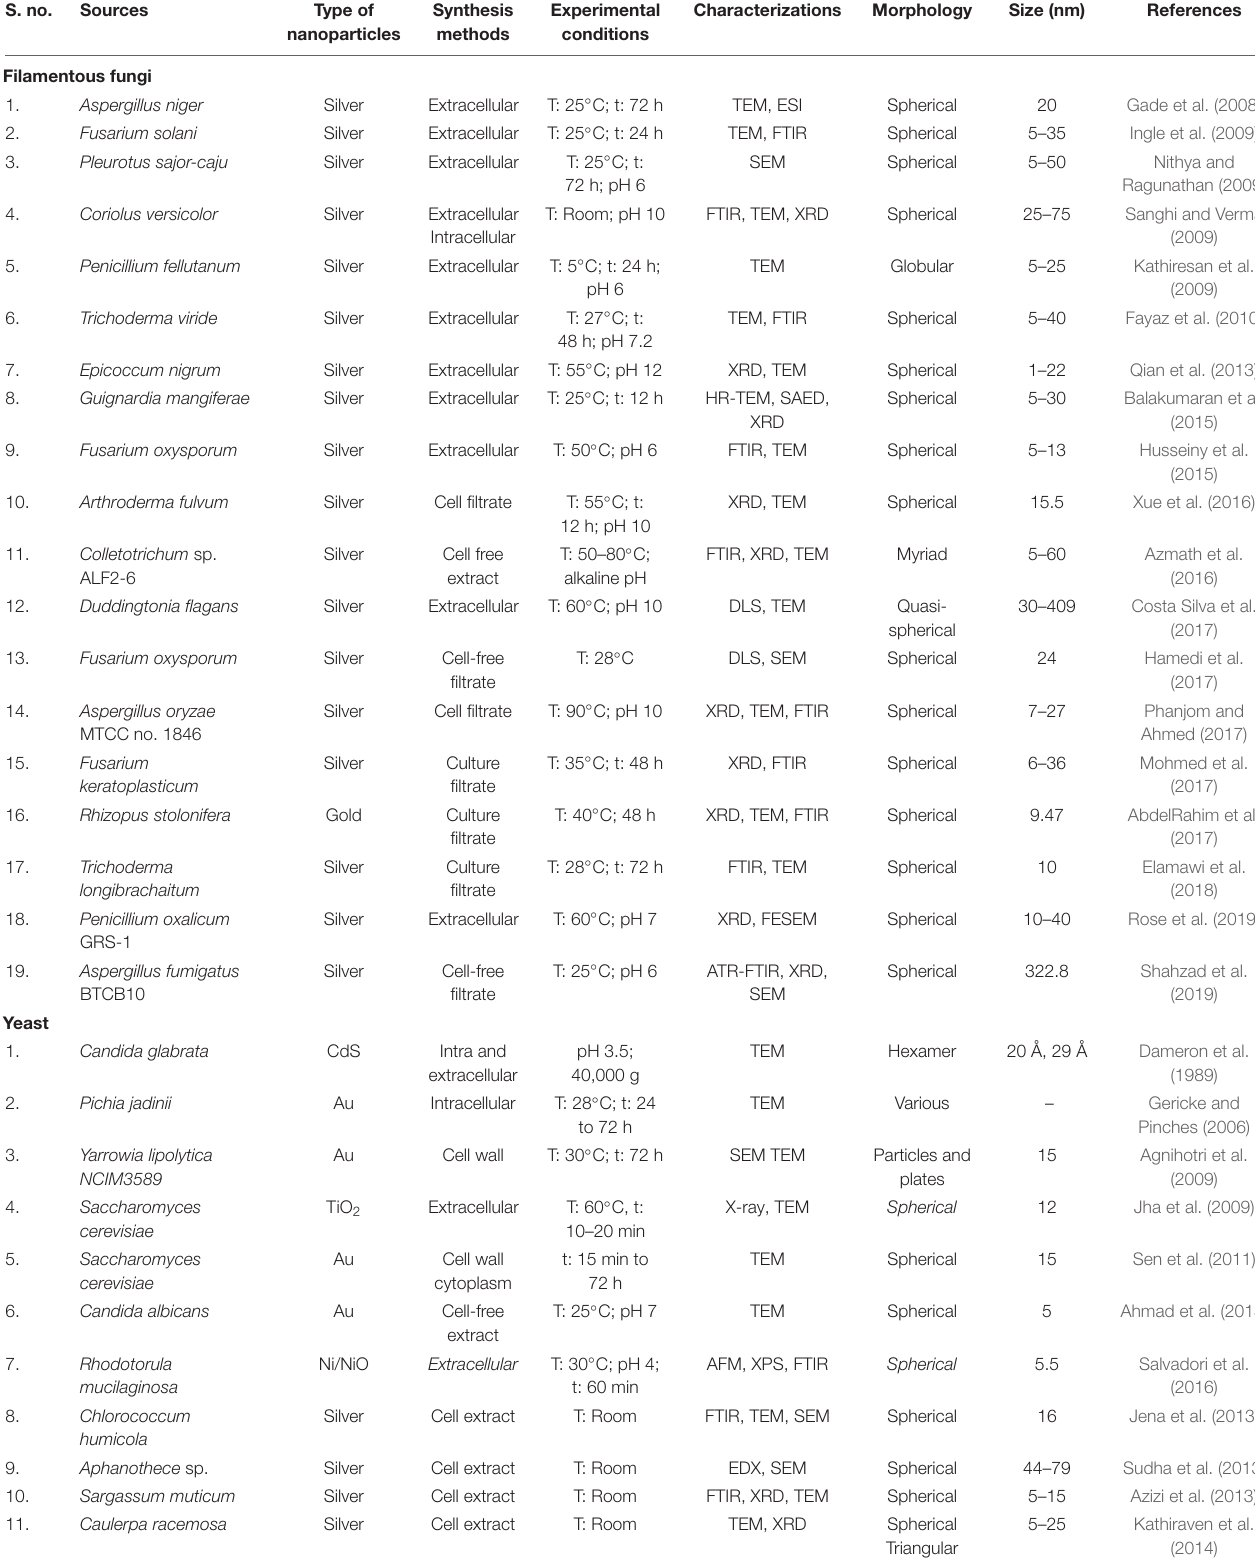
TABLE 1 | Biological synthesis of metal nanoparticles using different microbes. S.